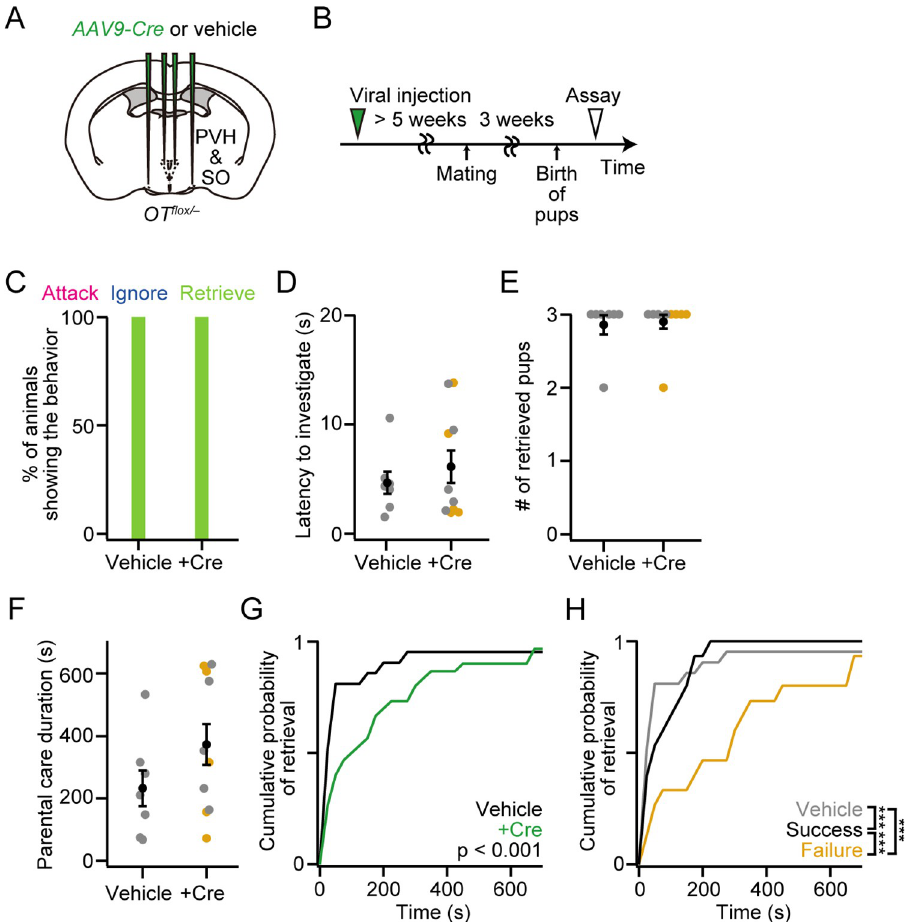
Fig 2. Grossly normal parental behaviors of mothers with OT cKO in the PVH and SO. (A) Schematic of the viral injection. AAV-Cre or vehicle was injected into the bilateral PVH and SO. (B) Schematic of the timeline of the experiment. A behavioral assay was conducted at PPD 3. (C) Percentage of mothers showing attack, ignore or retrieve. Note that attack or ignore was not observed in our dataset. (D) Latency to the first investigation of pups was not statistically different (two-sided Mann–Whitney U- test). (E) Number of retrieved pups. (F) Parental care duration was not statistically different (two-sided Mann–Whitney U- test). (G) Cumulative probability of pup retrieval. The p-value is shown in the panel (Kolmogorov–Smirnov test). (H) Cumulative probability of pup retrieval of vehicle dams (gray line), and +Cre dams that exhibited success (black line) or failure (orange line) in raising pups at PPD 1 ( ��� p < 0.001, Kolmogorov–Smirnov test with Bonferroni correction). n = 5 each for the success and failure phenotypes, respectively. n = 7 and 10 for vehicle and +Cre from the mice analyzed in Fig 1D, respectively. Orange dots indicate mothers with the failure phenotype. Error bars, standard error of the